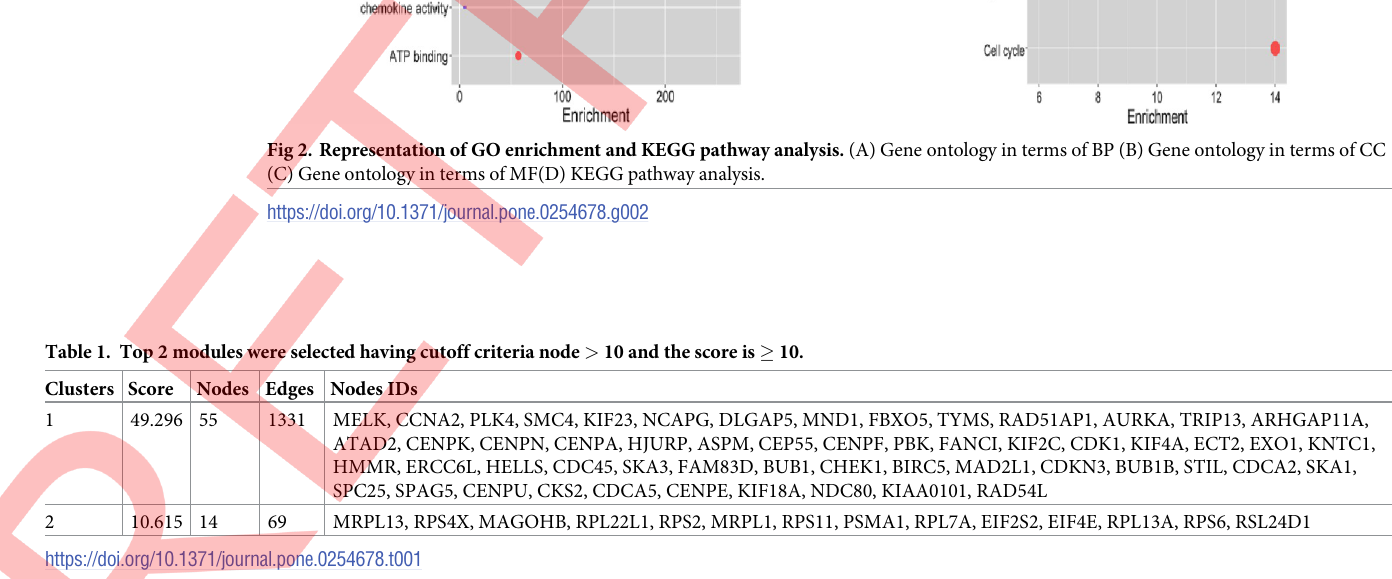
Table 1. Top 2 modules were selected having cutoff criteria node > 10 and the score is � 10. Clusters Score Nodes Edges Nodes